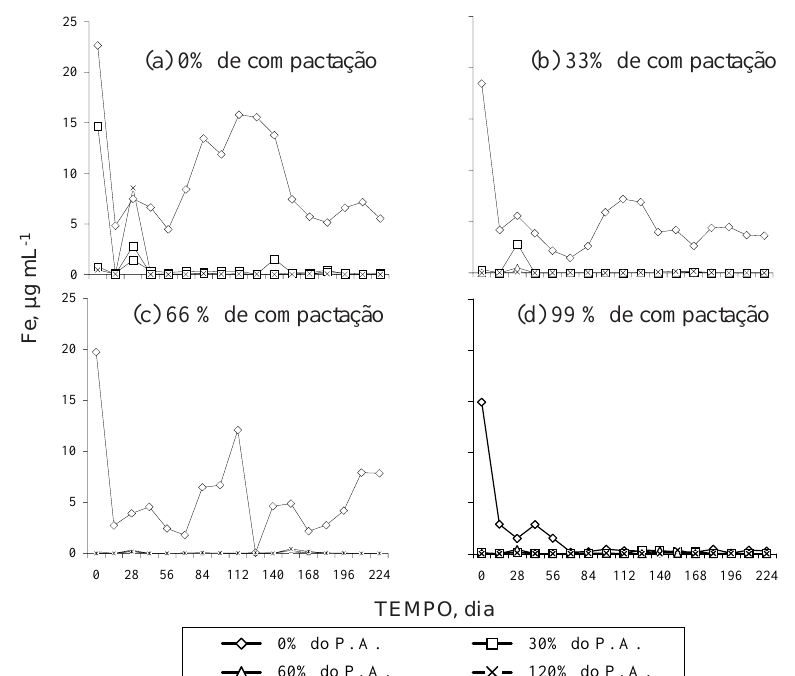
Figura 6. Teores de ferro nos lixiviados, considerando o tempo, para as diferentes doses de carbonato e níveis de